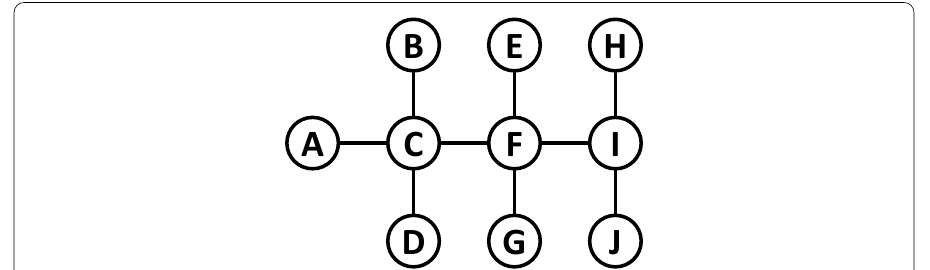
Fig. 1 A toy network with 10 nodes and nine undirected